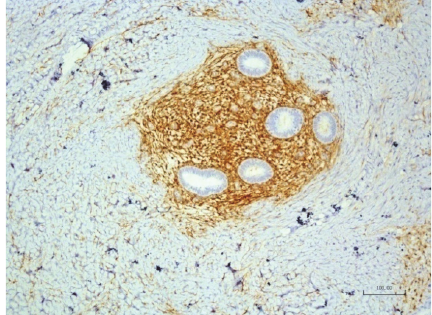
Figure 5: Positive immunohistochemically stained CD 10 endome- trial stroma (DAB ×